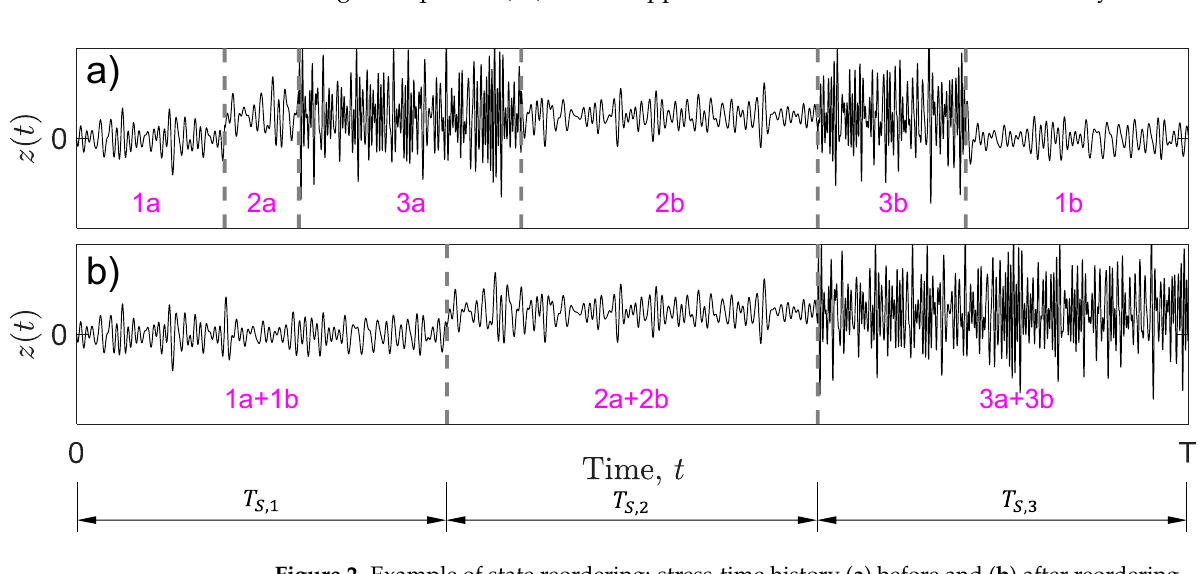
Figure 2. Example of state reordering: stress-time history ( a ) before and ( b ) after reordering.